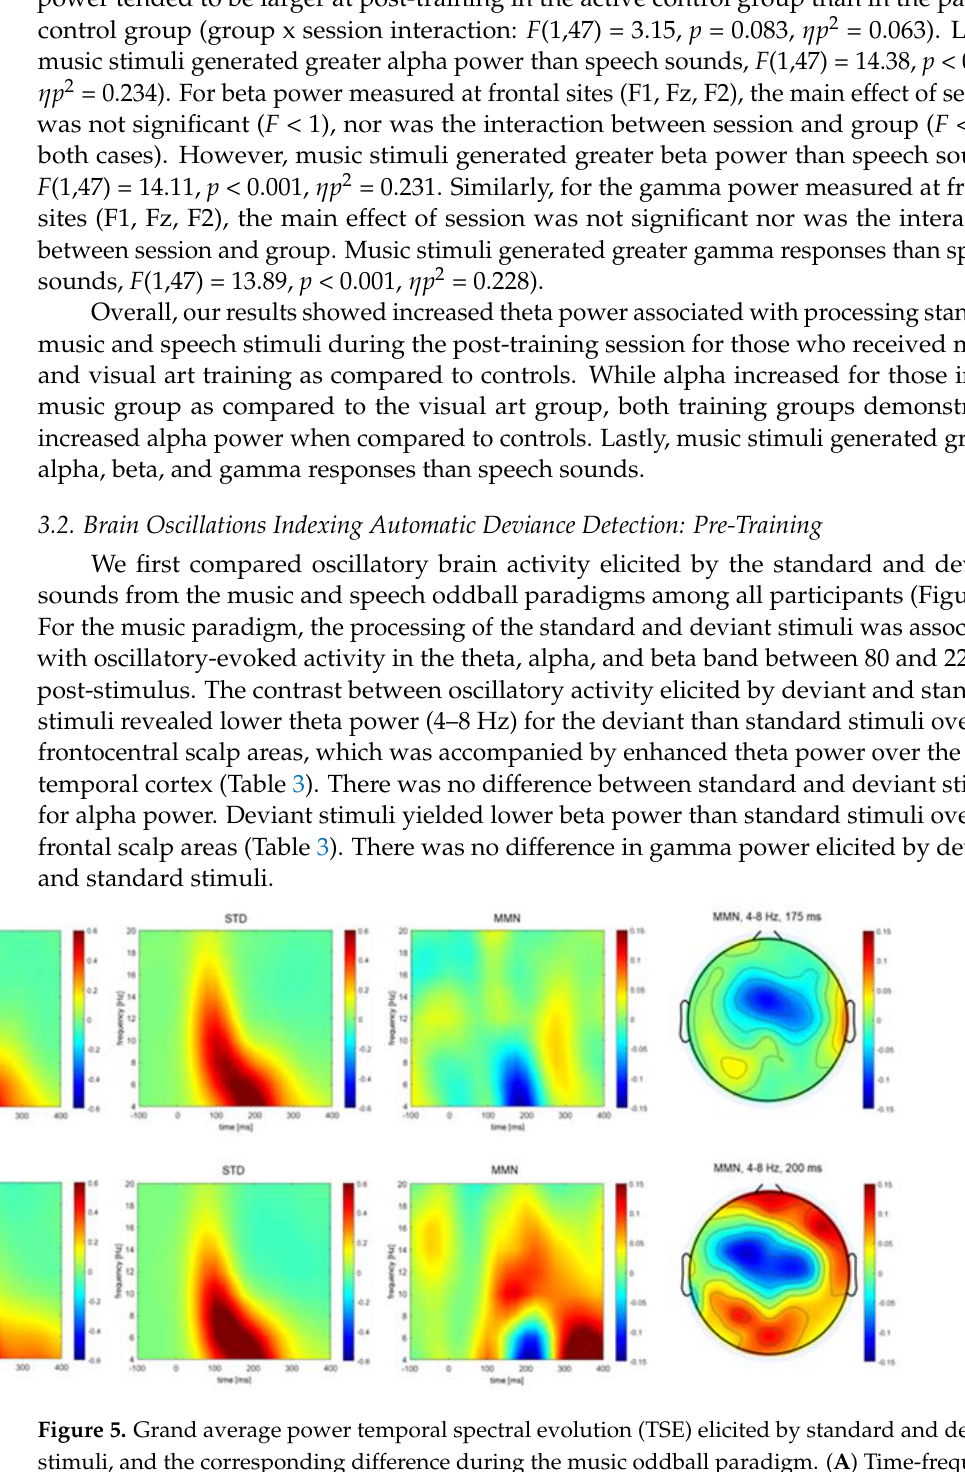
between 60 and 300 ms post ‐ stimulus. The clustered ‐ based permutation statistic revealed greater theta power for deviant than standard stimuli over right fronto ‐ temporal ‐ parietal cortex and over the left parietal cortex (Table 3). Occasional deviant speech sounds also